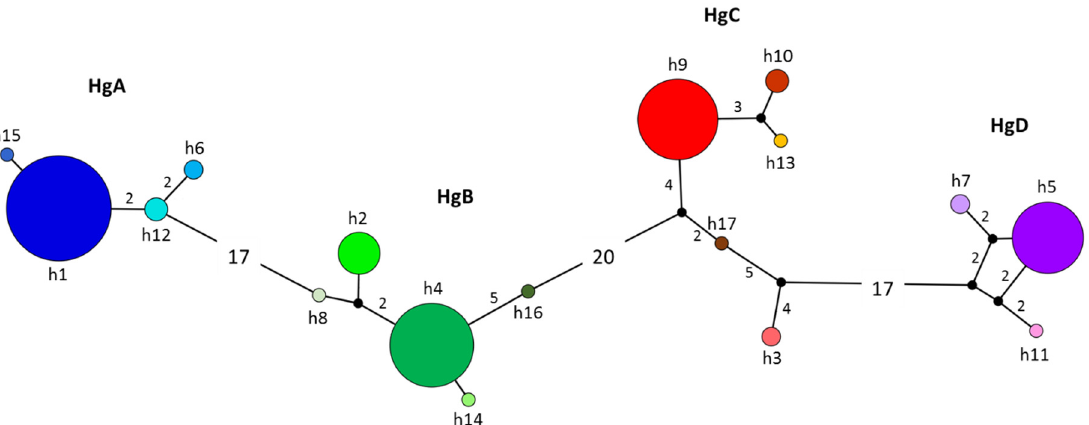
Figure 2. The haplotype network of P. vivax msp1 42 from 1993–2011 in southern Mexico. Each color corresponds to one haplotype. The number of samples containing each haplotype is indicated by the size of the circle. Black dots represent existing or extinct haplotypes not found in the samples. The number of mutational steps between haplotypes, if higher than one, is denoted. Four haplogroups were formed (HgA, HgB, HgC, and HgD). In the 198 sequences analyzed, haplotypes h1, h4, h5, and h9 were the most common, found at 31.8%, 21.2%, 14.6%, and 18.7%, respectively. Pvmsp1 42 haplotypes displayed a similar pattern of colors as in Figure 1.